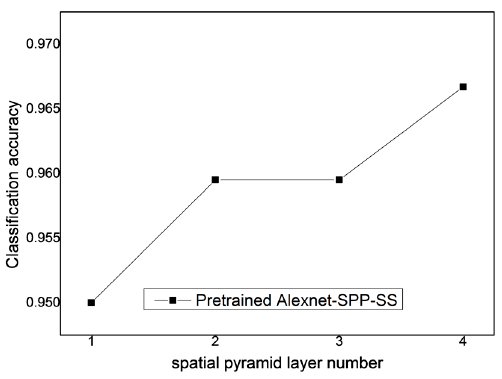
Figure 14. The influence of the spatial pyramid layer number for the pre-trained AlexNet-SPP-SS model with the UC Merced dataset.